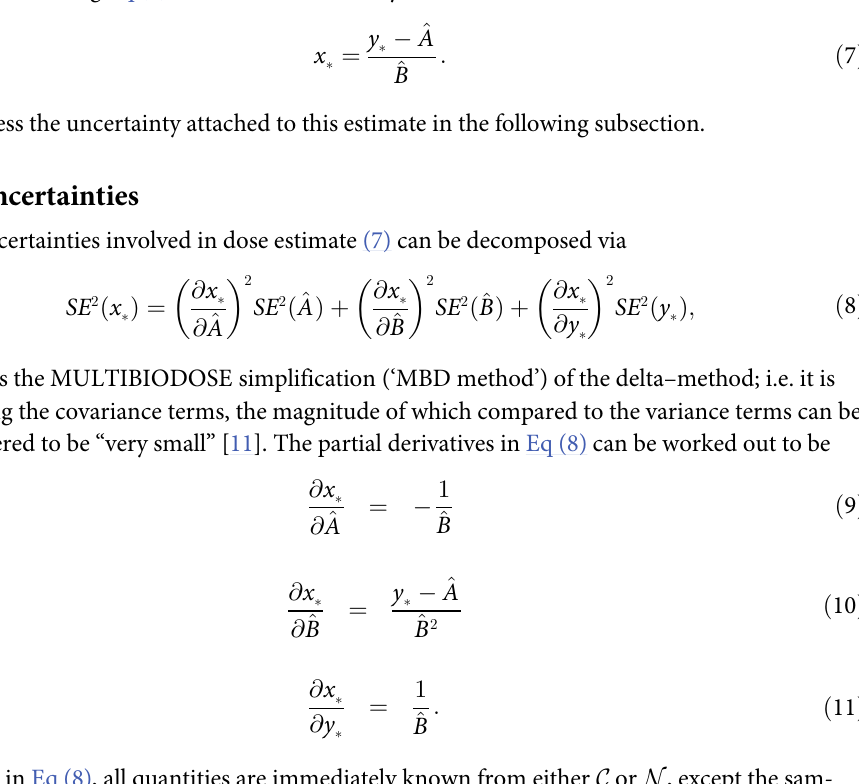
p ffiffiffiffiffiffiffiffiffiffiffi . = n y � �